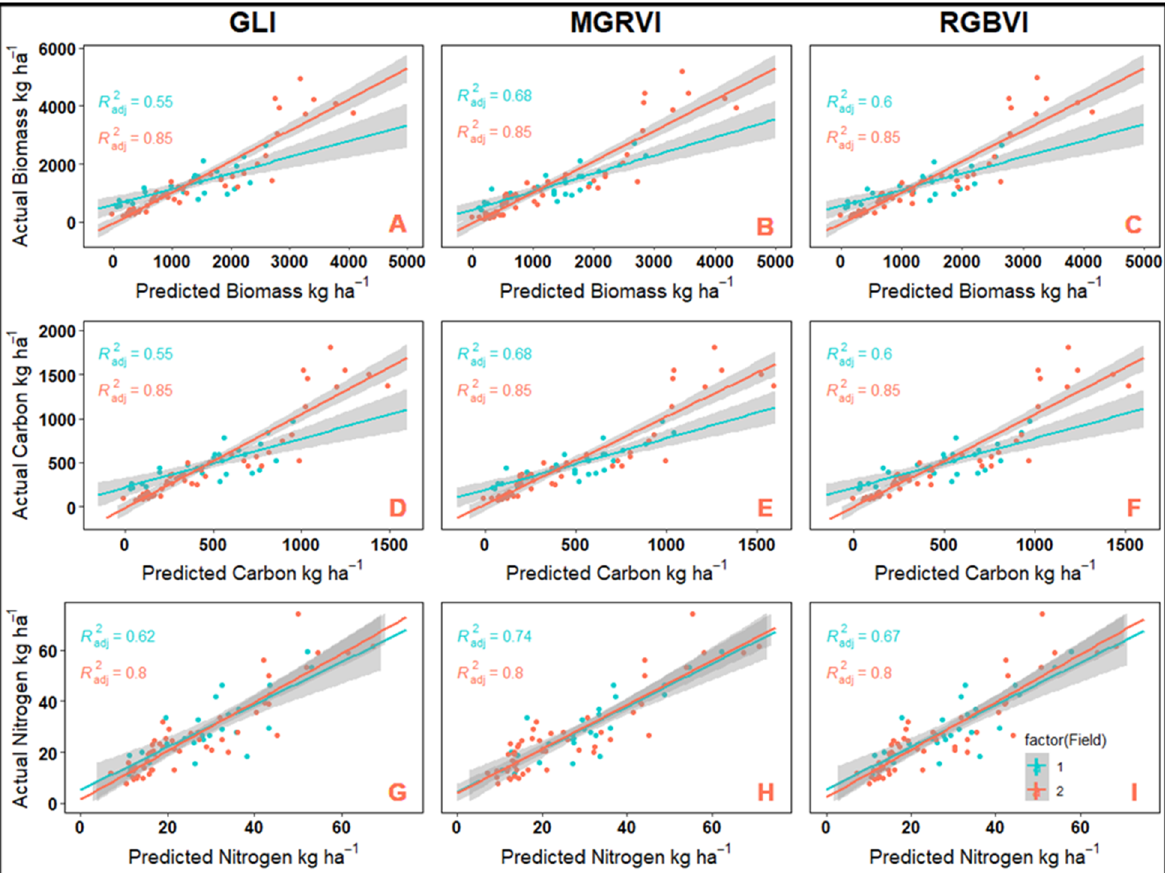
Figure 2. Correlation of in-field measured versus predicted values by field for cereal rye biomass, carbon, and nitrogen obtained from complex content-based models developed using green leaf index (GLI) ( A —biomass, B —carbon, and C —nitrogen), modified green red vegetation index ( D —biomass, E —carbon, and F —nitrogen), and red green blue vegetation index ( G —biomass, H —carbon, and I —nitrogen).